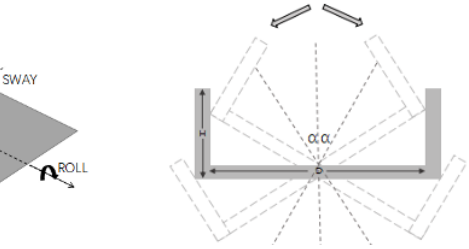
Fig. 1. Vessel motions in 6 degrees of freedom. Fig. 2. Roll amplitude.